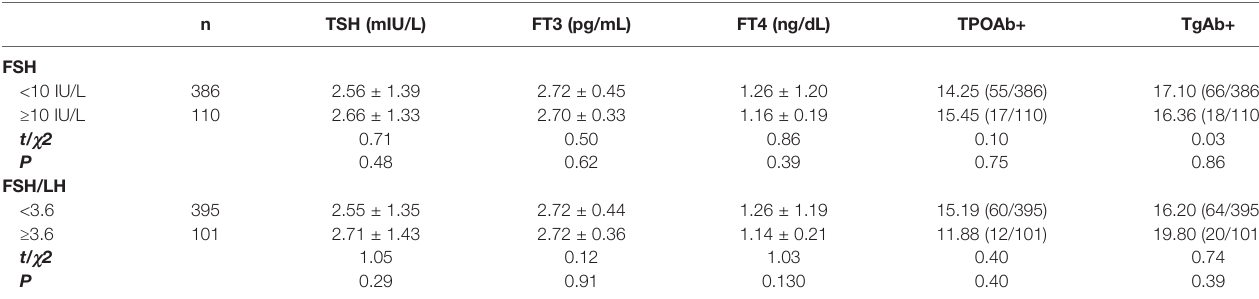
TABLE 7 | Comparison of thyroid hormone in women with different FSH.